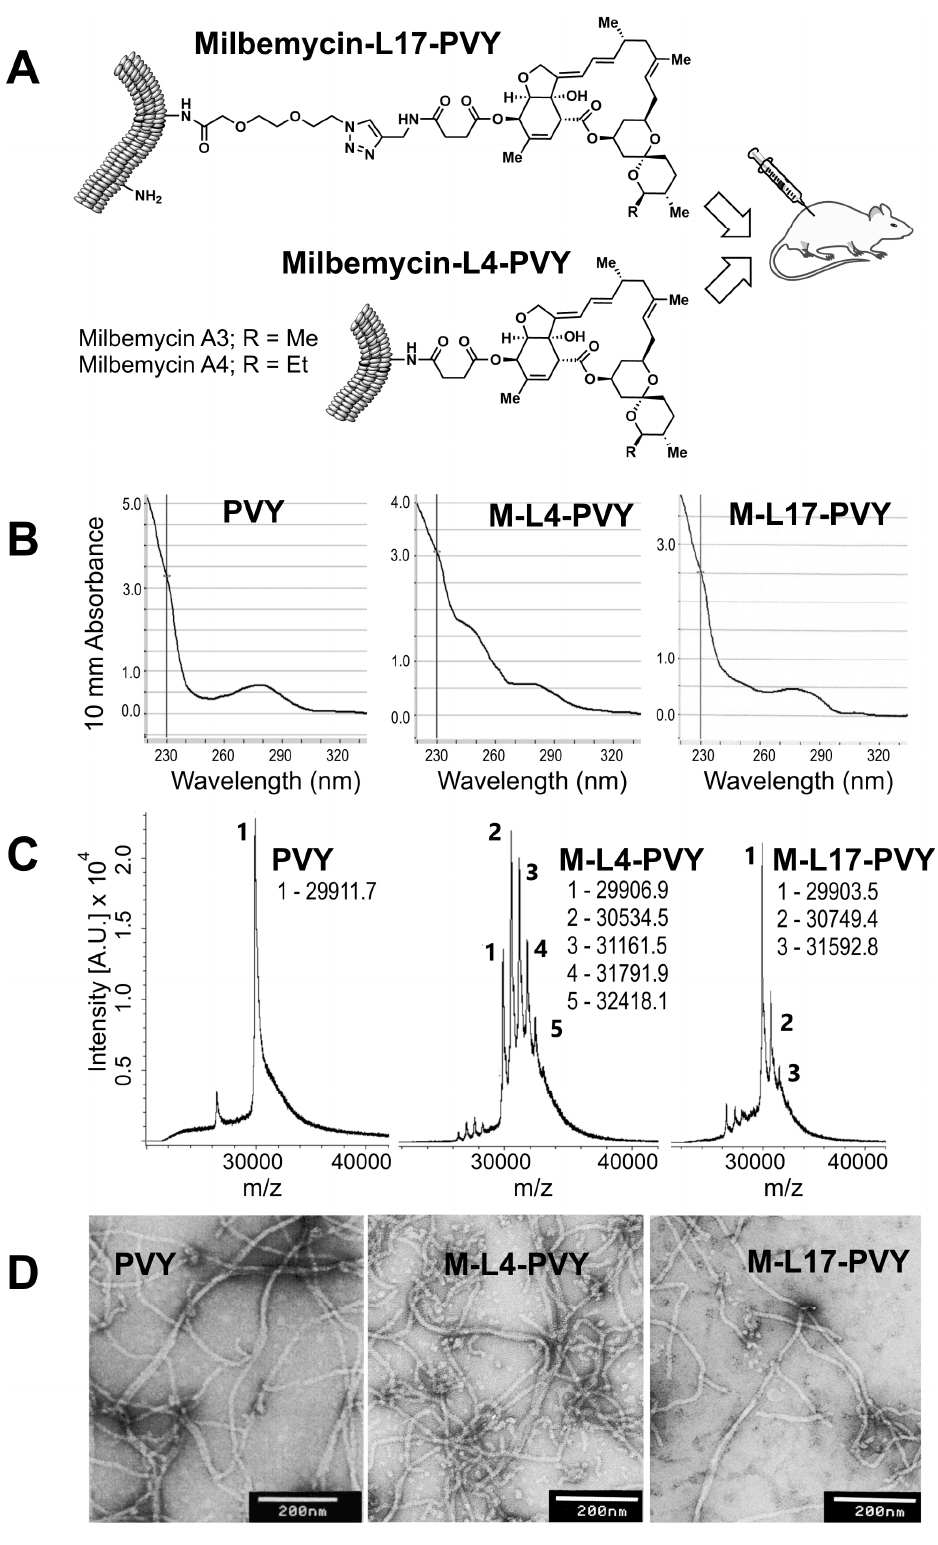
Figure 1. The characterization of synthesized milbemycin-PVY conjugates. ( A ) Chemical structures of milbemycin-L17-PVY (M-L17-PVY) and milbemycin-L4-PVY (M-L4-PVY) used in mice immunization experiments; ( B ) UV spectra of PVY-VLPs (left) and their derivatives M-L4-PVY (in the middle) and M-L17-PVY (right); ( C ) Mass spectrometric analysis of PVY-VLPs (left) and their derivatives M-L4-PVY (in the middle) and M-L17-PVY (right); ( D ) Electron microscopy images of PVY-VLPs (left) and their derivatives M-L4-PVY (in the middle) and M-L17-PVY (right). White bar—200 nm.